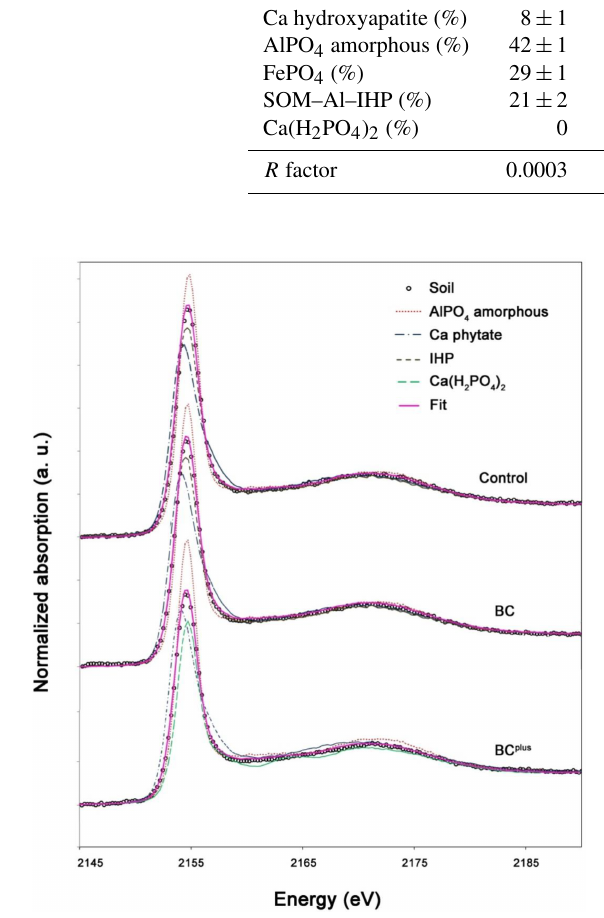
Figure 4. P K -edge XANES spectra of unfertilized (control) and fertilized soils with BC and BC plus particles under 230 days of rye- grass cultivation compared to the reference compounds selected by the LCF method.